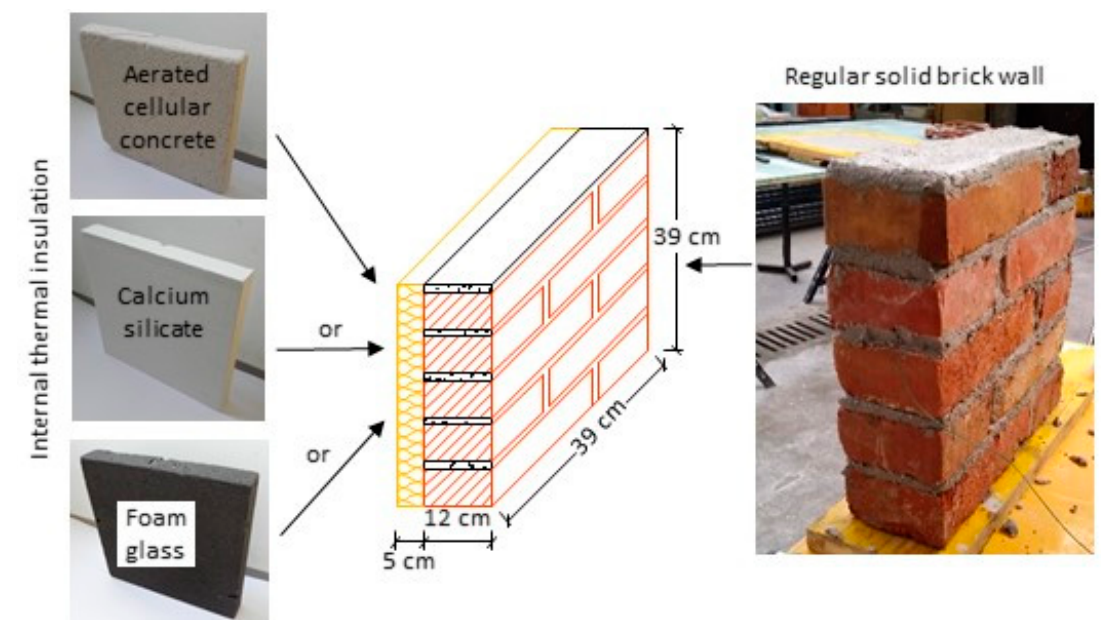
Figure 1. The test walls consist of different internal thermal insulation on the hot side and the brick wall (original wall) on the cold side. Units are in cm.